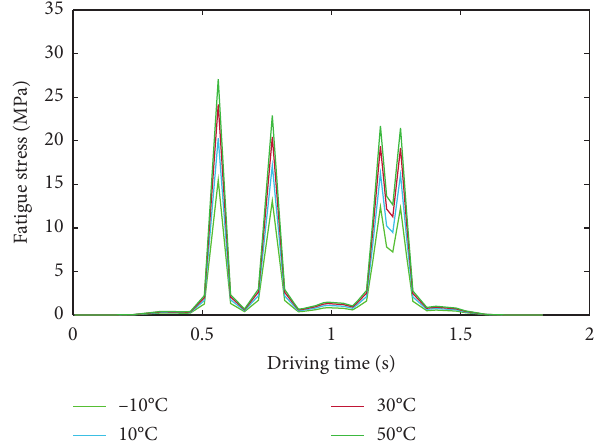
Figure 3: The fatigue stresses at different temperatures at moni- toring point A .